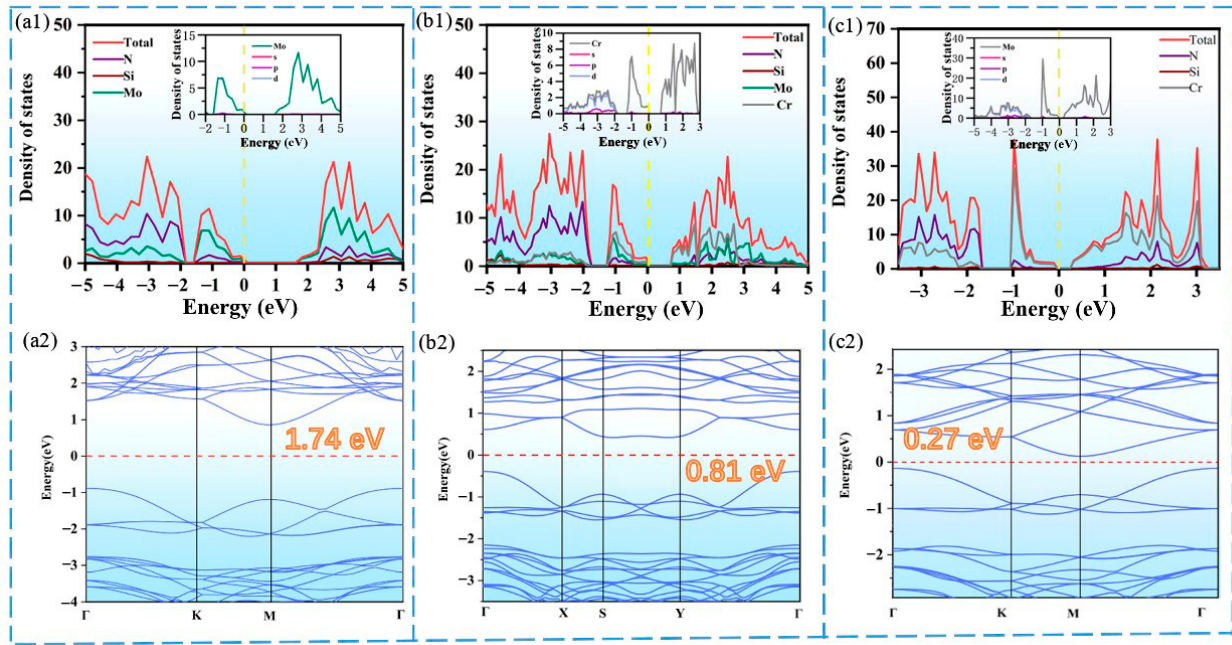
Figure 2. Total density of states (DOS), partial DOS (PDOS) in 2D structures and band of ( a 1 ) MoSi 2 N 4 , ( b 1 ) Mo 0.5 Cr 0.5 Si 2 N 4 and ( c 1 ) CrSi 2 N 4 , in which the PDOS of orbitals of the corresponding middle layers are also shown as an insert. The band structure of each type of atom is shown in Figure 2 (( a 2 ) MoSi 2 N 4 , ( b 2 ) Mo 0.5 Cr 0.5 Si 2 N 4 and ( c 2 ) CrSi 2 N 4 ), which taking the symmetry point of the Brillouin zone as the X -axis, where K, M, etc., are the high symmetry points of the Brillouin zone of the crystal, which vary according to the symmetry of the point group of the crystal.